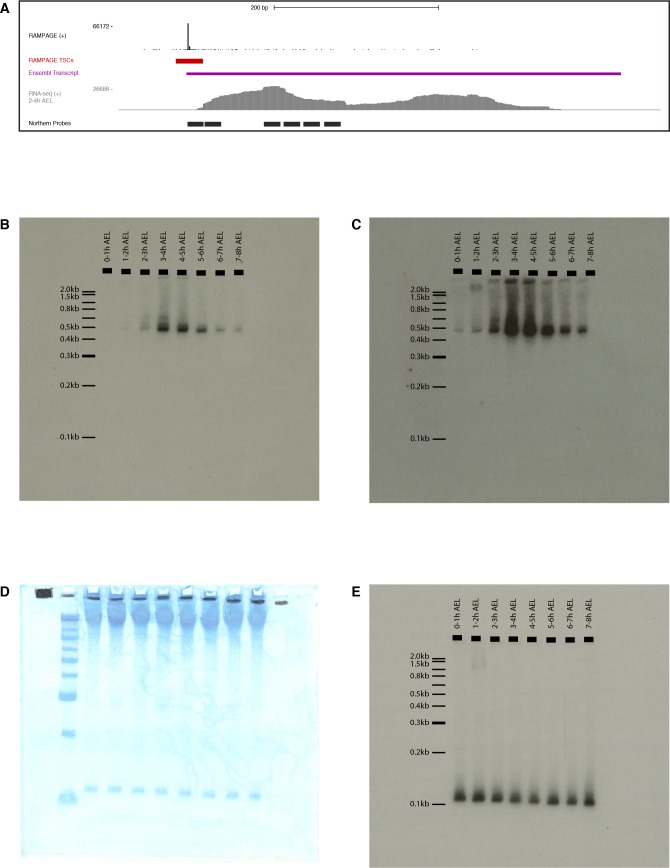
FBgn0264479 Northern-blot.(A) Description of the probes. Tracks from top to bottom: RAMPAGE signal, TSC, Ensembl transcript annotation, RNA-seq signal (modENCODE, 2–4 hr time point), FBgn0264479 probes (antisense to target). We used a mix a all six radiolabeled oligonucleotide probes. (B) Exposure of the whole membrane, hybridized with anti-FBgn0264479 probes. (C) Same blot, longer exposure. (D) Methylene blue staining of the membrane prior to hybridization. First lane: Invitrogen 0.1–2.0 kb RNA ladder. (E) Hybridization with anti-5S rRNA probe.